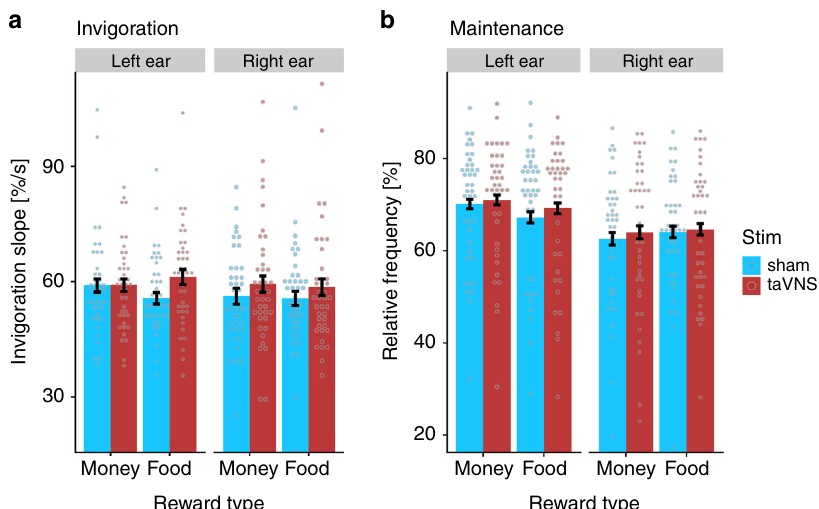
Fig. 3 Transcutaneous auricular vagus nerve stimulation (taVNS) increases invigoration. a During taVNS, participants were faster to invigorate instrumental behavior (stimulation main effect, p = 0.004, BF 10 = 7.34). The invigorating effect of taVNS was signi fi cantly more pronounced for food vs. monetary rewards (stimulation × reward type, p = 0.049) which was primarily driven by stimulation side (cross-level interaction, p = 0.037). b In contrast to invigoration, taVNS did not enhance effort maintenance compared to sham, p = 0.09, BF 10 = 0.51. n = 7776 trials of 81 participants; dots depict condition means per participant; bars depict data as sample mean values; error bars depict 95% con fi dence intervals at the trial level. %/s = button press rate in % per s. Note that apparent differences between sham conditions were not signi fi cant due to considerable inter-individual differences ( p s > 0.072). Statistics refer to two-sided t-contrasts of the mixed-effects models reported in Supplementary Tables 1, 2, approximate degrees of freedom = 78, no adjustments for multiple comparisons. Bayes factors were calculated using Bayesian two-sided t -tests based on order-corrected ordinary least squares effects of individual estimates. Source data are provided as a Source Data fi le.